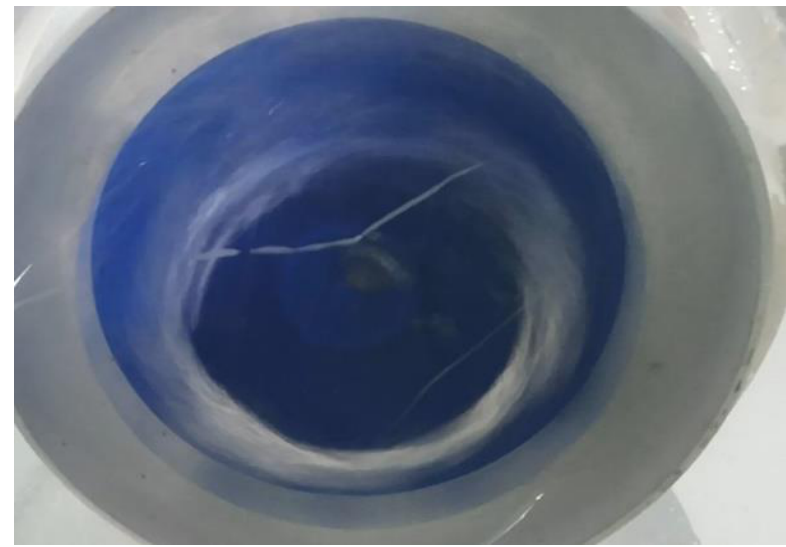
Figure 17. Bubble inside hood of the vortex ( δ = 0.6).